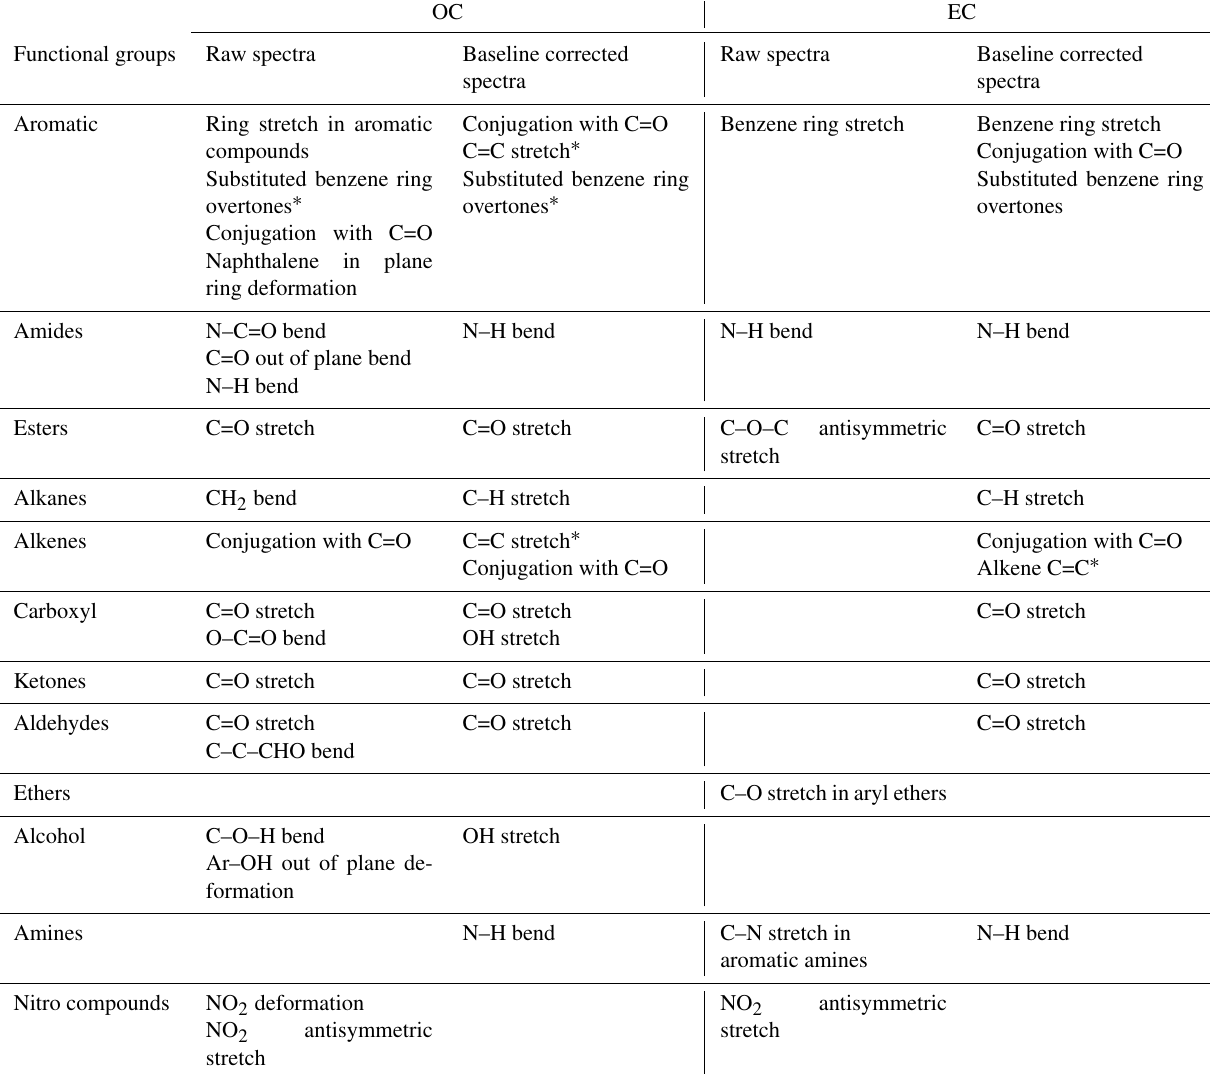
Table 2. Summary of FG and associated vibrational modes with positive regression coefficients used in the prediction of TOR OC and TOR EC by EN–PLS method. The FGs that are common to every solution (both raw and baseline corrected solution for TOR OC and EC) are reported first, followed by non-oxidized FGs, oxygenated FGs, and nitrogenated FGs; the order is not indicative of